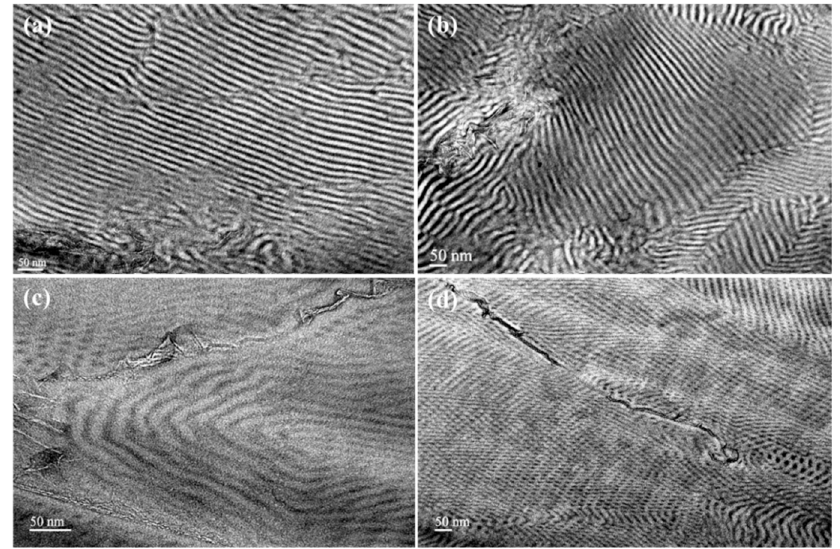
Figure 3. Bright field TEM images corresponding to the ( a ) 1-PS- b -PI- g -CMGs 1%, ( b ) 1-PS- b -PI- g -CMGs 3%, ( c ) 2-PS- b -PI- g -CMGs 1%, and ( d ) 2-PS- b -PI- g -CMGs 3% final composite materials after thermal annealing at 120 °C for 48 h, sequential microtoming, and staining with vapors of OsO 4 for approximately 2 h.